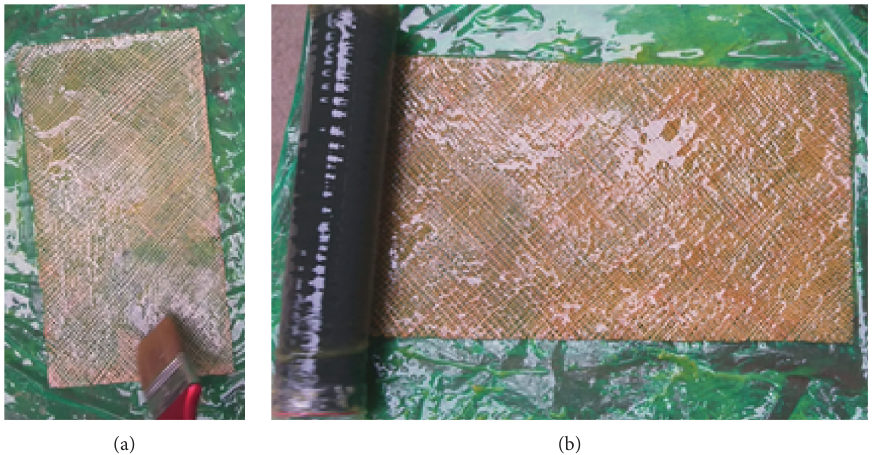
Figure 5: Hand layup process: (a) adding resin mixture and (b) roving rolling to remove air.